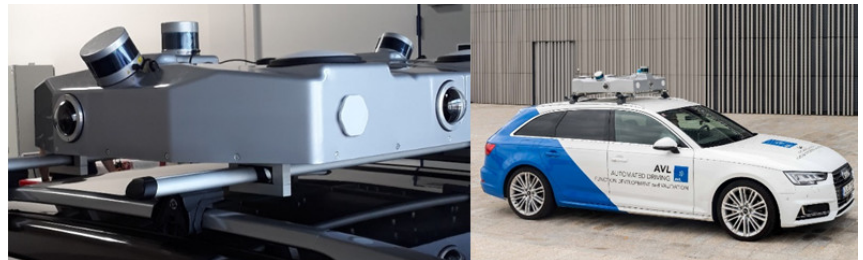
Figure 15. AVL Dynamic Ground Truth rooftop